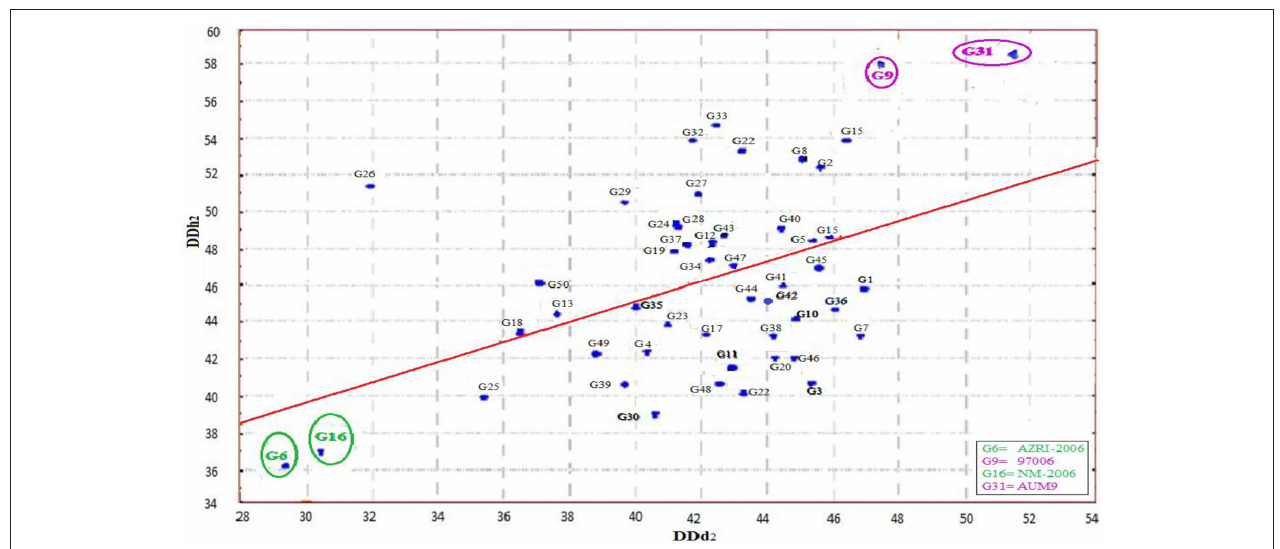
FIGURE 1 | Scatter plot of DDd 2 against DDh 2